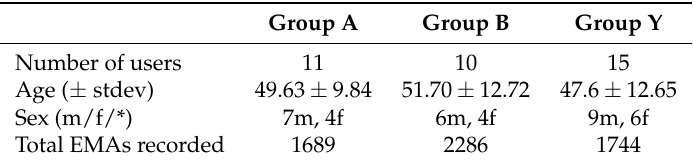
Table 2. User Groups A, B & Y: Basic